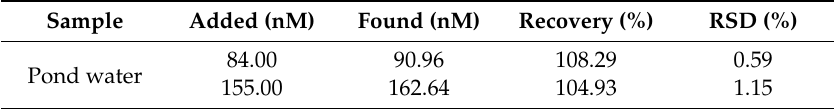
Table 1. Determination of Hg 2+ in real water samples ( n =